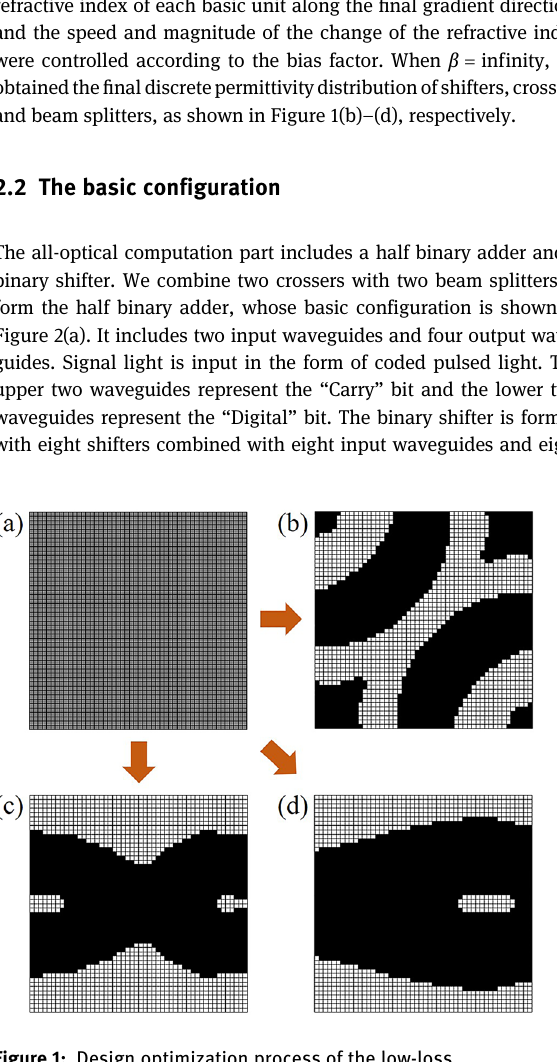
Figure 1: Design optimization process of the low-loss